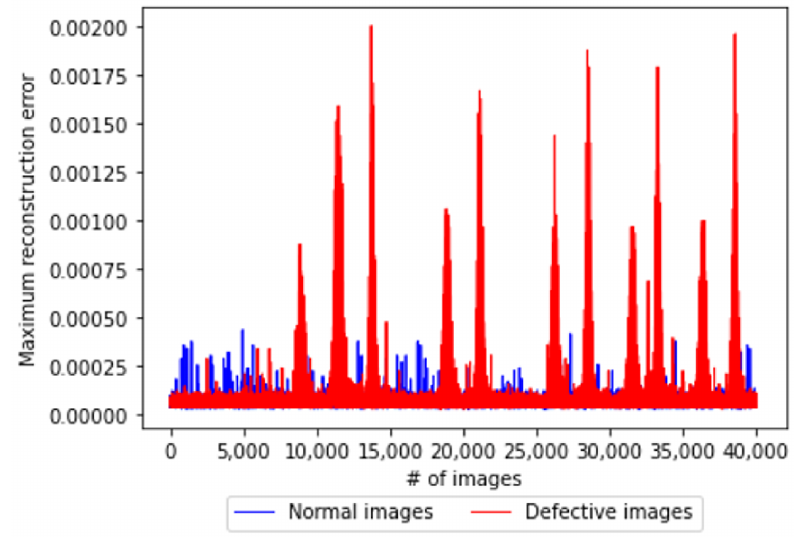
Figure 11. Maximum reconstruction error of the images from the experiments.